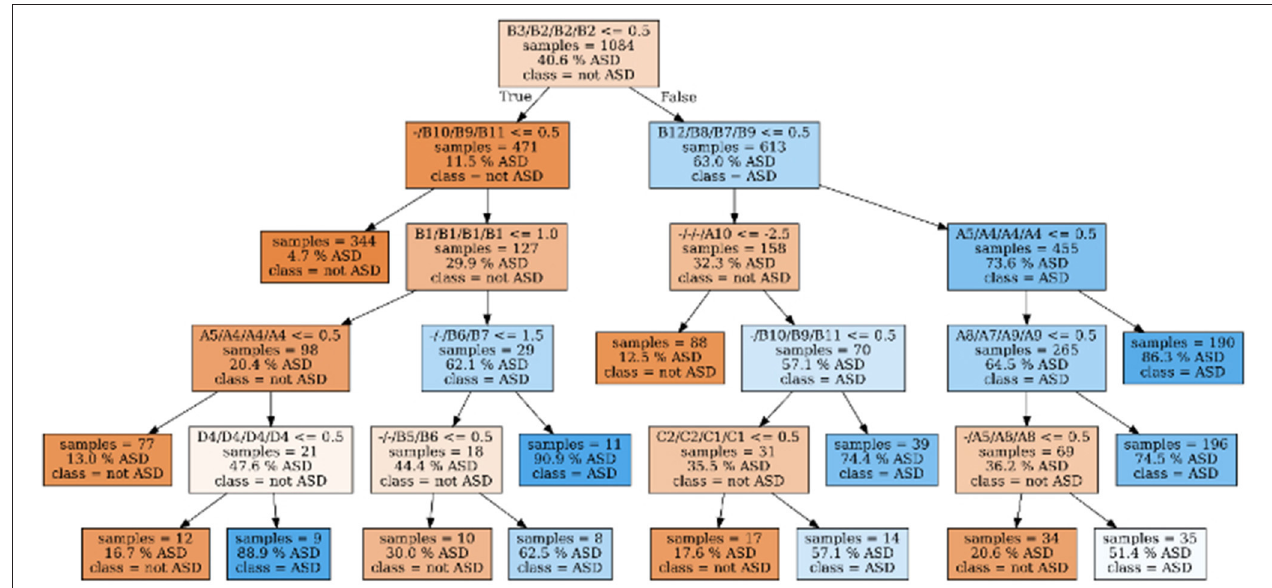
FIGURE 4 | Feature importance for the trained random forest classifier. Features’ importance have been normalized so that they sum to 1. All features used in this study are shown. The features corresponding to ADOS items are reported in the order M1/M2/M3/M4 according to their content. Features that do not appear in all modules are marked with a “-” to indicate that they do not appear in the respective